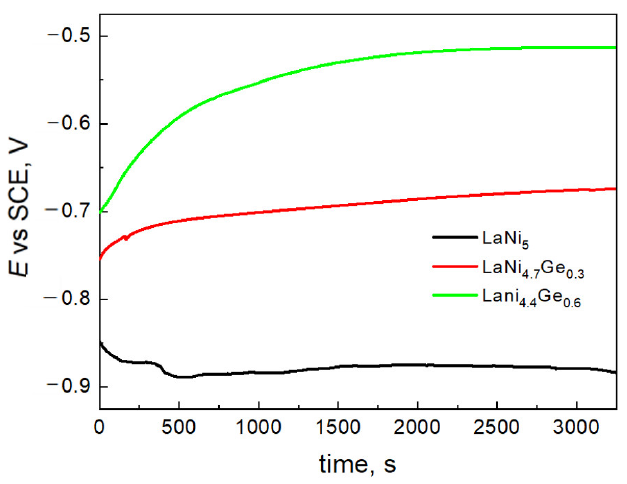
Figure 3. The open circuit potentials changes of LaNi 5- x Ge x alloys in 6 M KOH electrolyte. The open circuit potentials, i.e., the corrosive potentials of LaNi 4.7 Ge 0.3 and LaNi 4.4 Ge 0.6 are −0.7 V and −0.5 V, respectively, and are therefore significantly shifted in